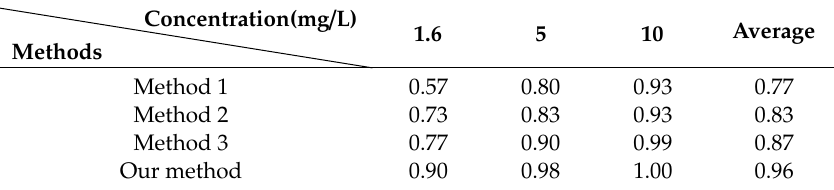
Table 5. Recognition results of the four